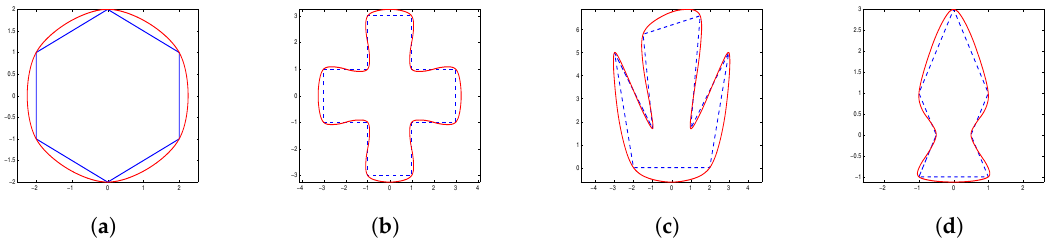
Figure 1. Examples of the rational interpolation subdivision schemes with C 2 continuity. ( a ) Behavior of the schemes for α = − 1; ( b ) Behavior of the schemes for α = 0; ( c ) Behavior of the schemes for α = 1; ( d ) Behavior of the schemes for α = 3.